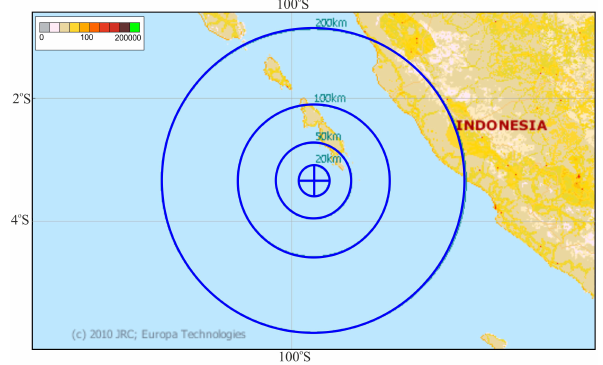
Fig. 9. Population density near epicenter (peoplekm − 2 ) (JRC, 2010).